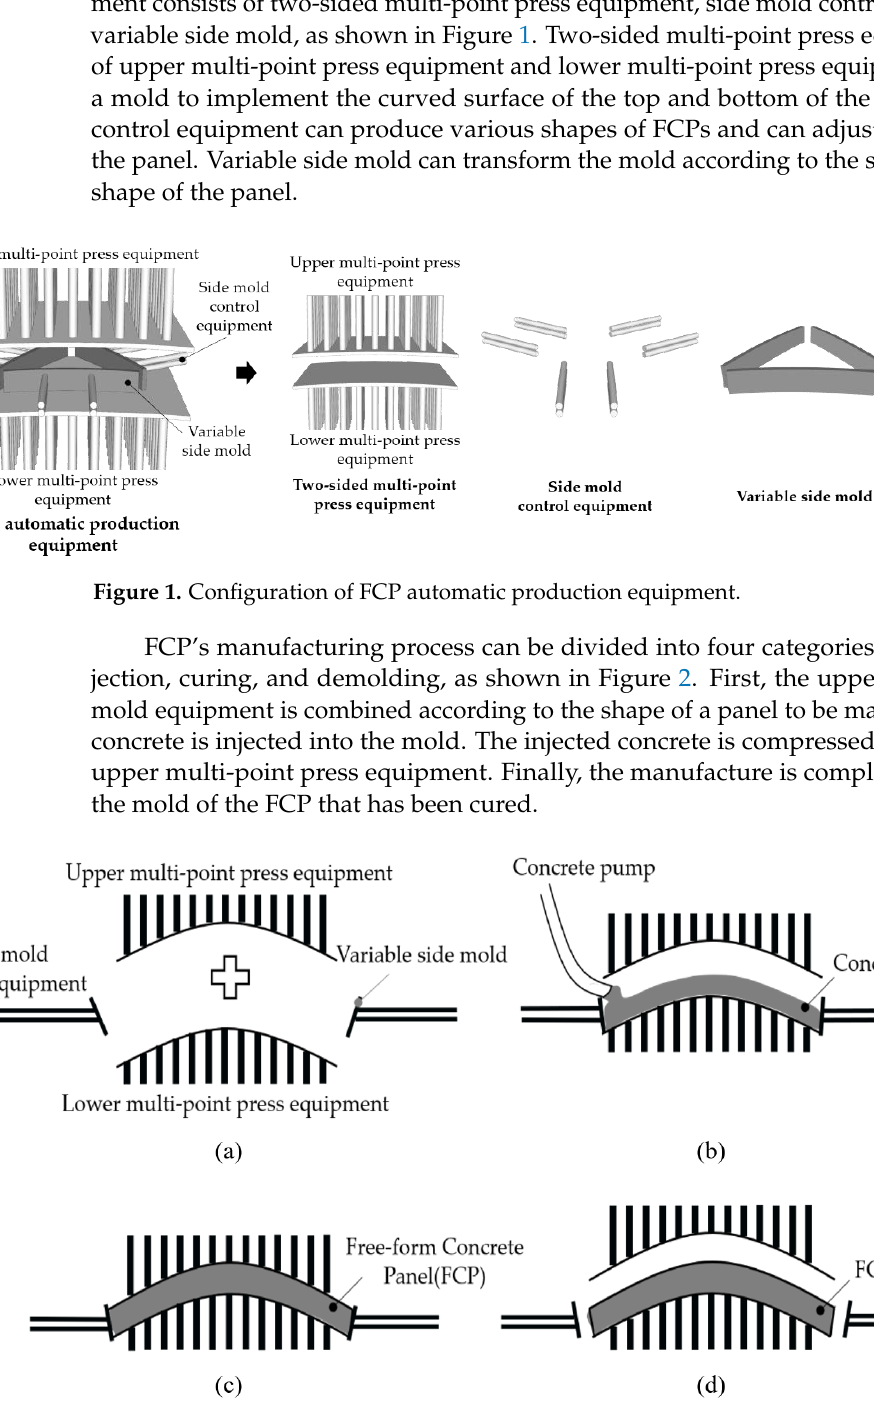
Figure 2. Process of manufacturing FCP: ( a ) Mold combination; ( b ) Concrete injection; ( c ) Concrete compressing and curing; ( d ) Demolding.